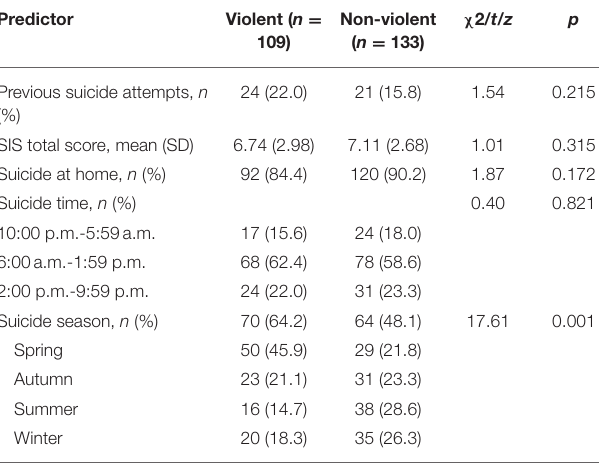
TABLE 2 | Conditional logistic regressions of risk factors on violent and non-violent suicide methods. Variables